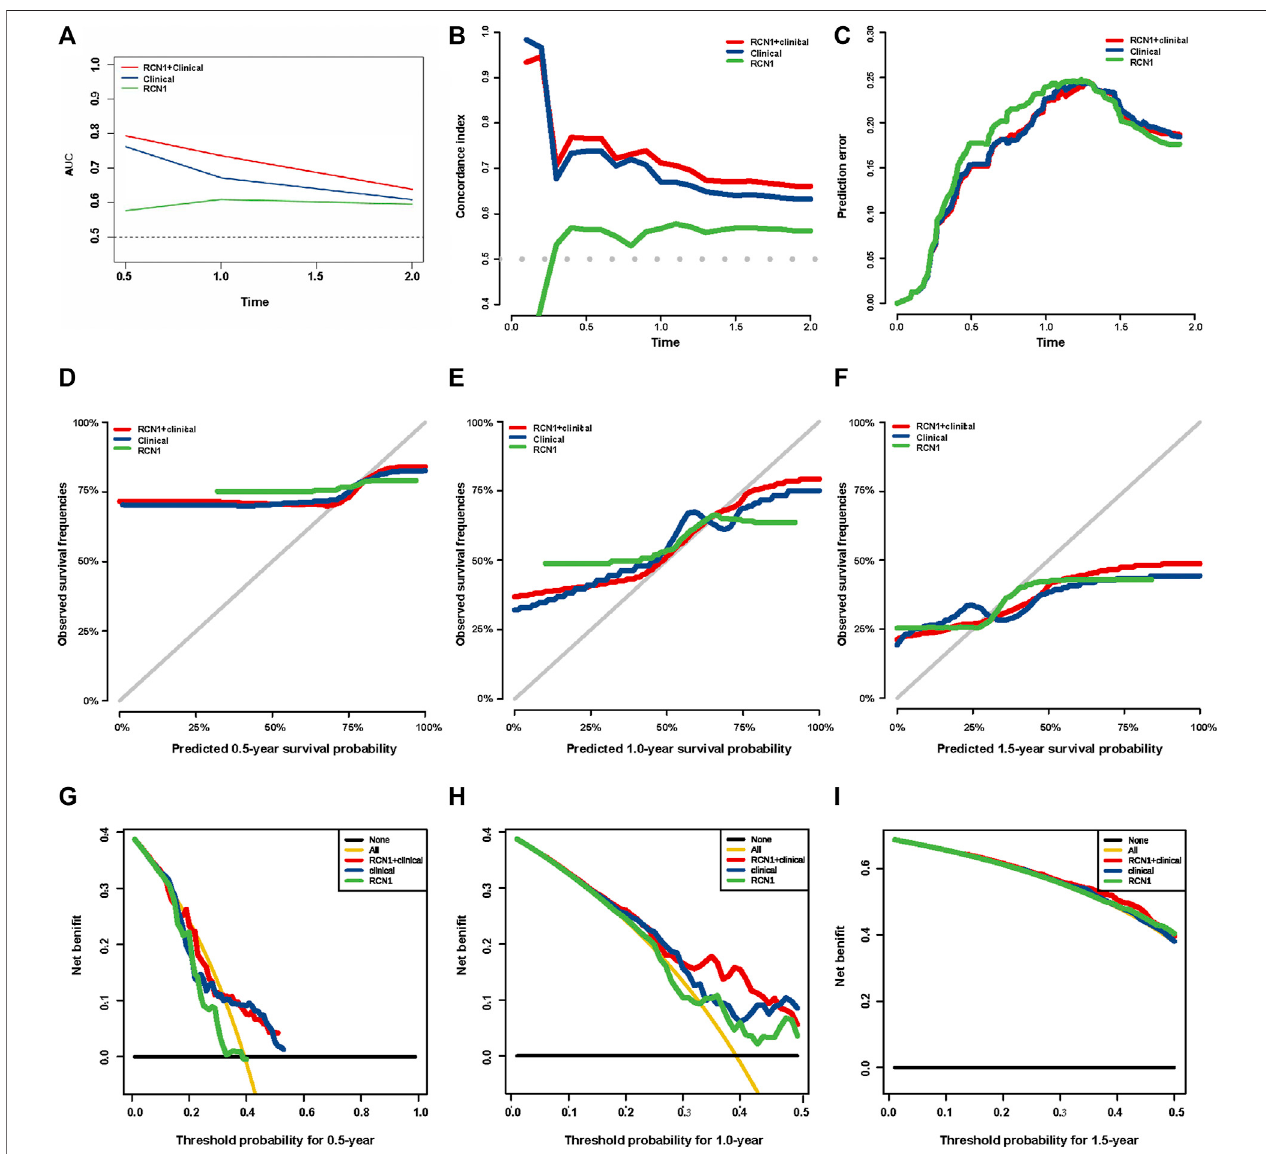
FIGURE 4 | Evaluation of three prognostic models in TCGA. (A) ROC curves of the three models at different times. (B) C-index curves of the three models at different times. (C) Prediction error probability curves of the three models at different times. (D – F) Calibration curves of the three models at different times. (G – I) DCA curves of the three models at different times.